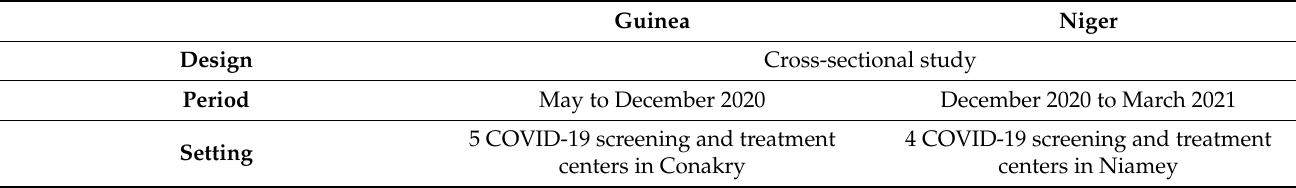
Table 1. Integration of TB screening in COVID-19 care in Niger and